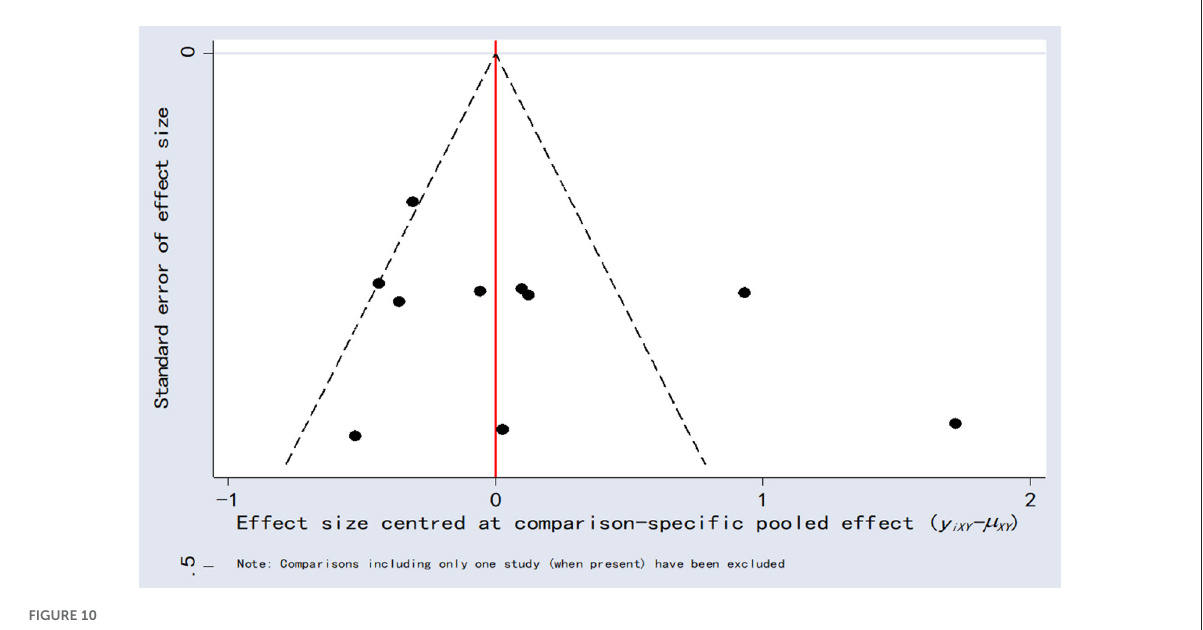
FIGURE10 Comparison-correction funnel